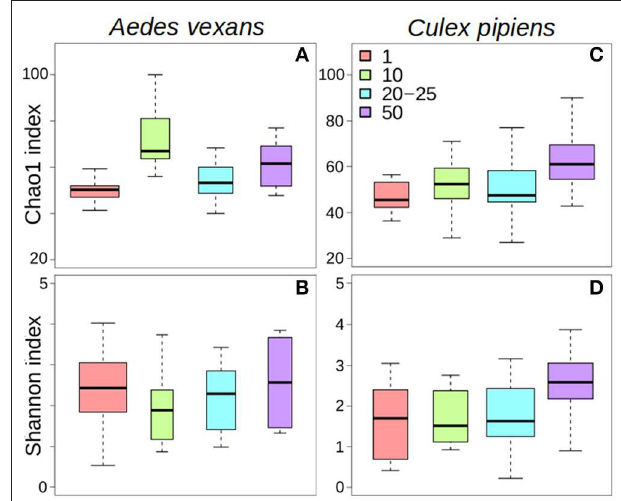
FIGURE 1 | Box-plots showing the alpha-diversity of Aedes vexans and Culex pipiens microbiomes according to the number of mosquitoes pooled per